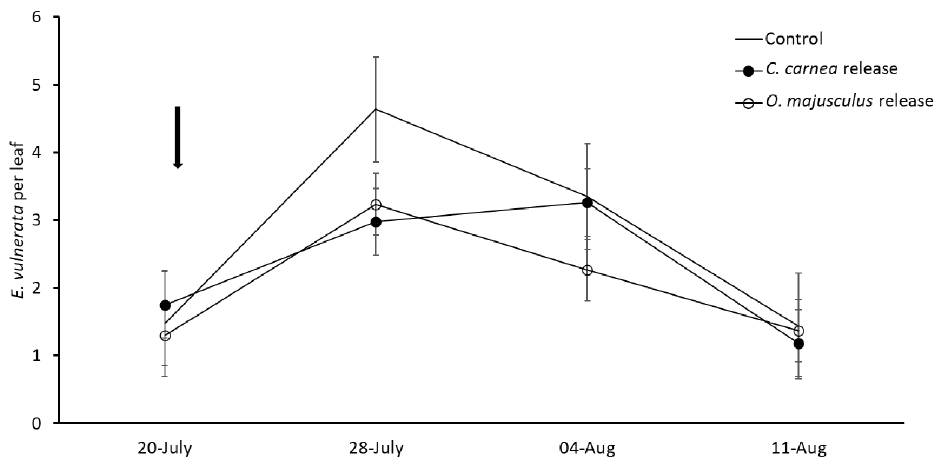
Figure 6. Erasmoneura vulnerata densities (mean ± SE) in vineyard plots characterized or not by predator releases (experiment 1, 2018). The arrow indicates the predator release event.